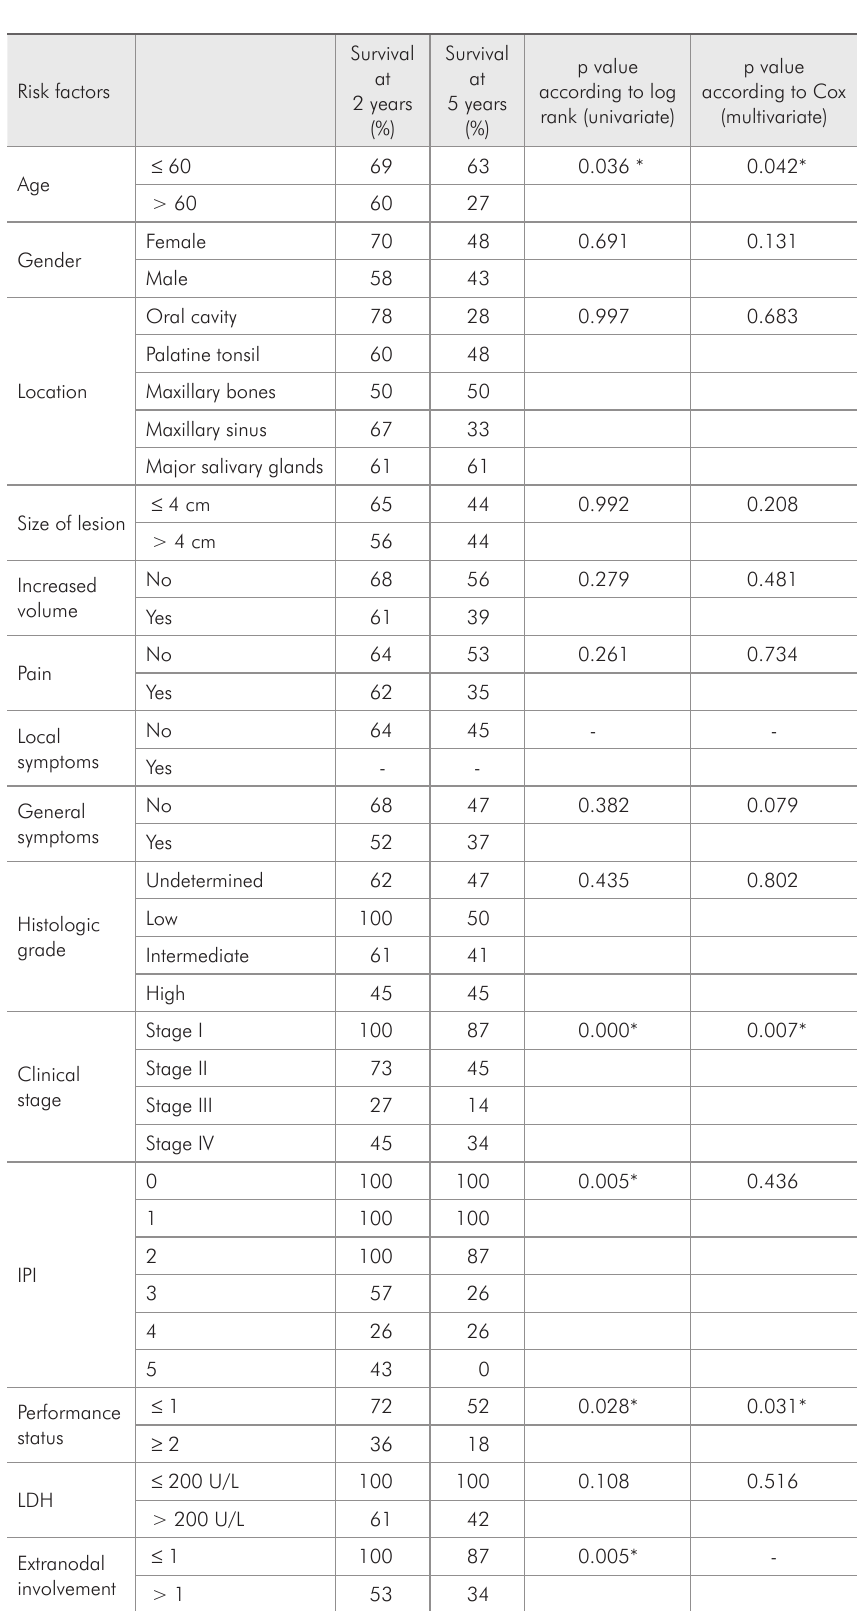
Table 1 - Percent survival at 2 and 5 years evaluated for possible prognostic factors for subjects with DLBCL of the